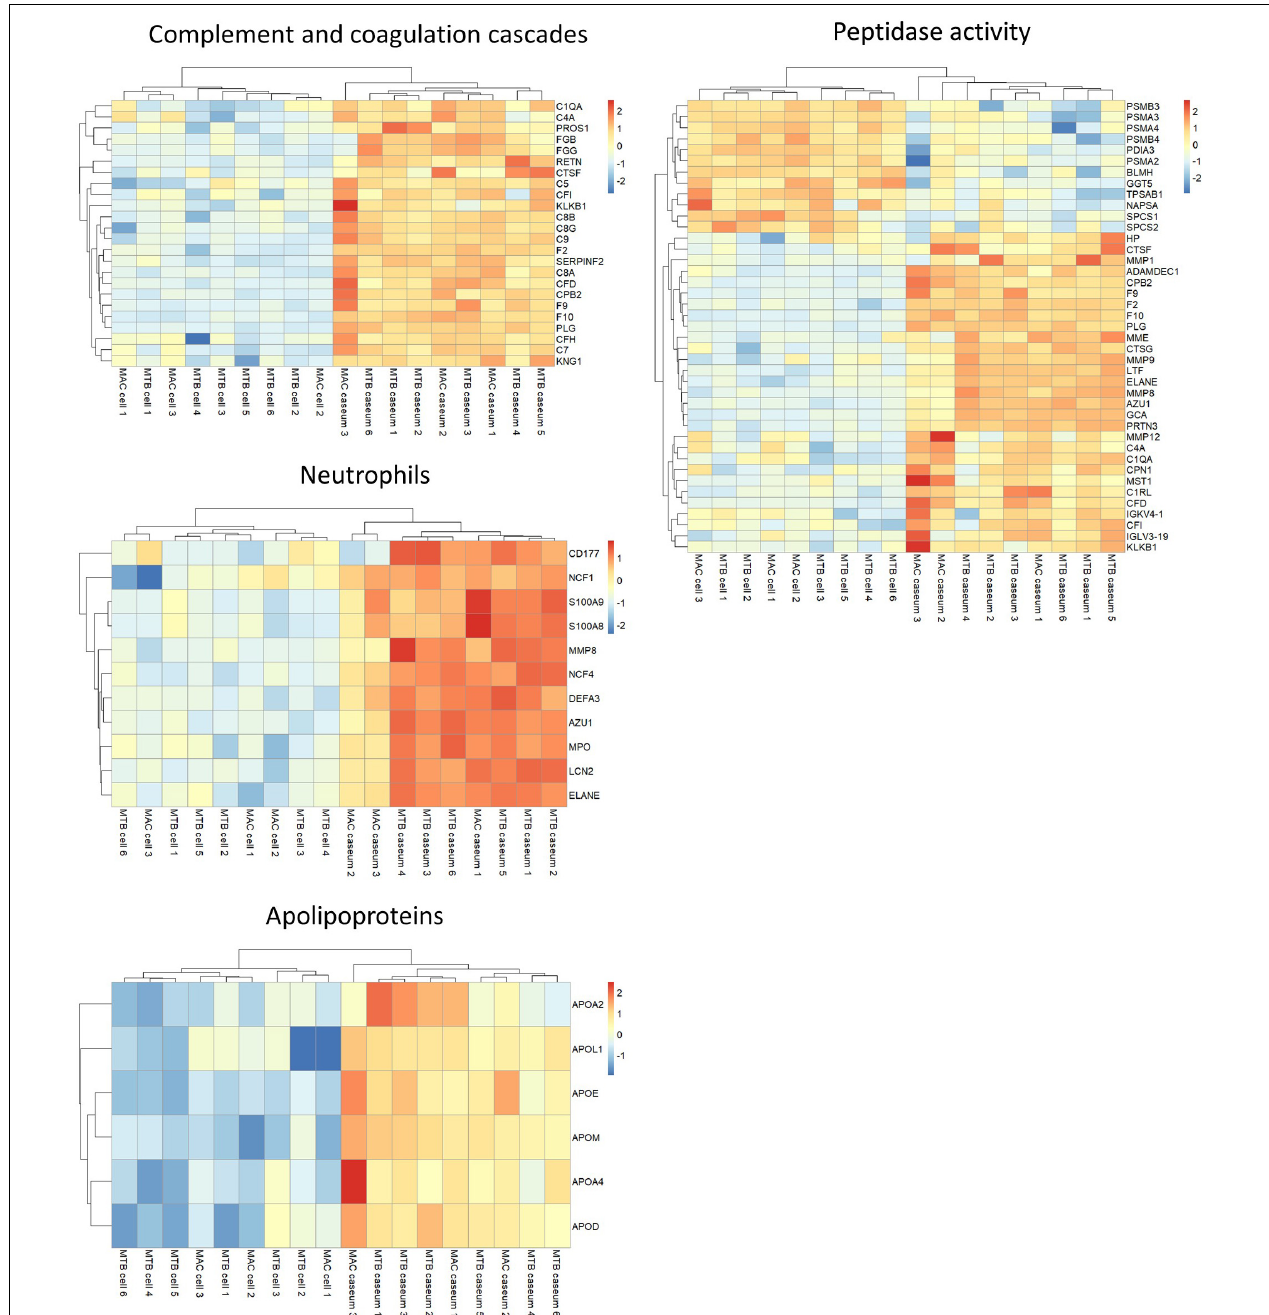
FIGURE 4 | Heatmap based on LFQ intensity values of selected proteins. Hierarchical-clustering-based on LFQ intensity values of proteins involved in complement and coagulase cascades, neutrophils, apolipoproteins and peptidase activity are presented. Names of proteins involved in the pathways are also indicated.